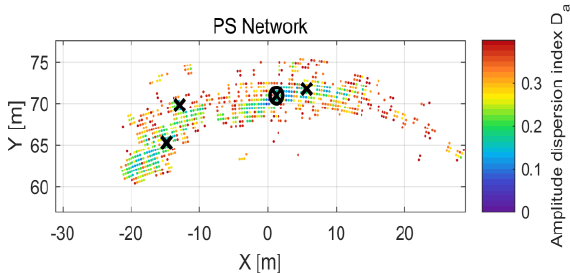
Figure 10. Result of selected PS points.